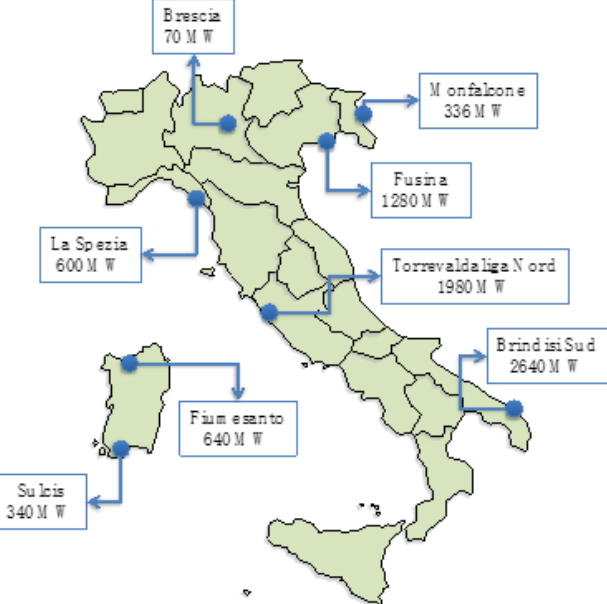
Figure 4. Italian coal power plants location and rated power [50].